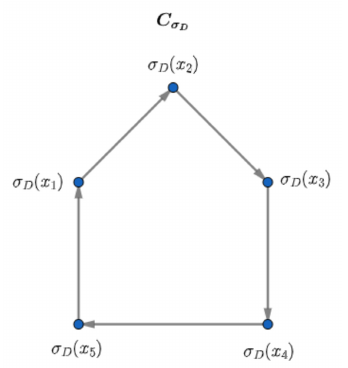
Figure 11. The minimal dominating set of C σ (cid:40) ∑ ) = min γ ( P σ σ D ( x ) : i = 1,2, . . . D σ D ( x ) ∈ X i